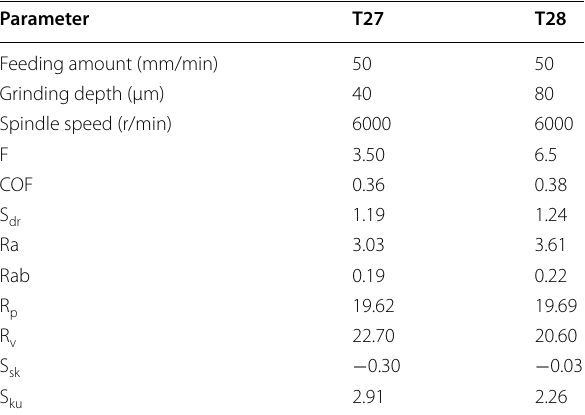
Table 7 Experimental parameters comparison of T27 and